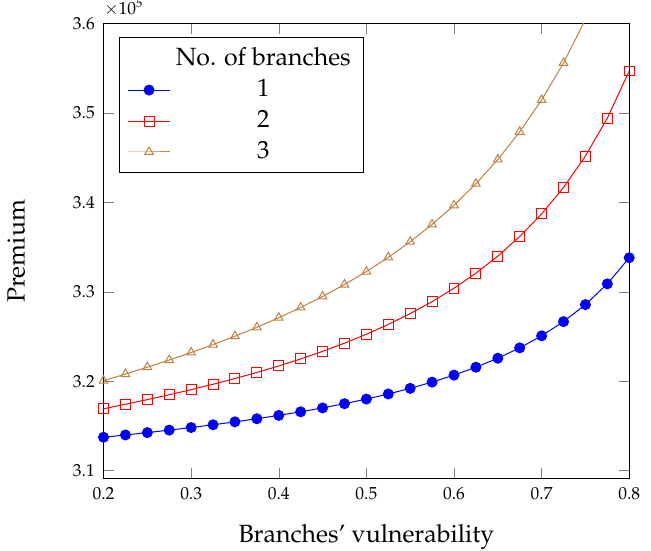
Figure 5. Premium paid by the headquarters in the full liability